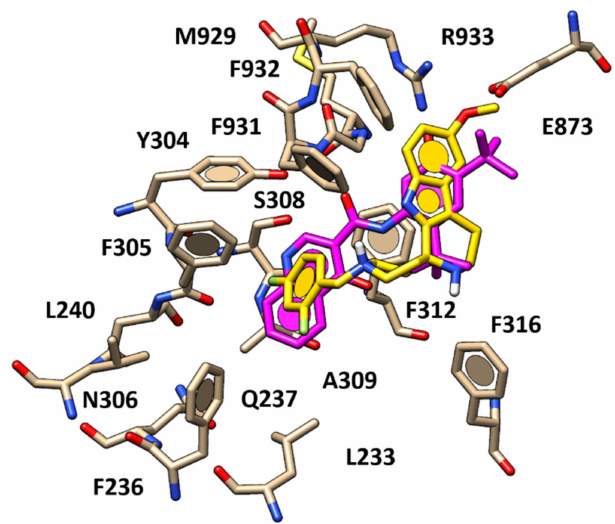
Figure 9. Docking positioning of compound 58 ( C atom; yellow) within the X-ray crystallographic structure of the human CFTR in the presence of the docked VX-770 ( C atom;